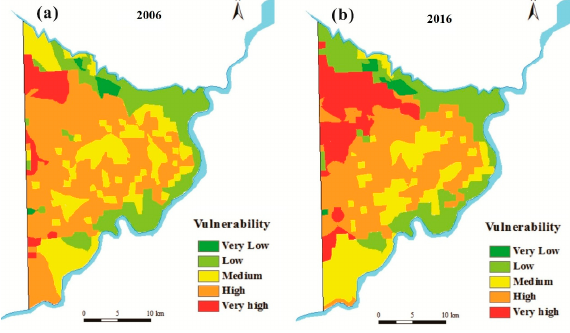
Figure 5. Spatial maps of land use types ( a , b ); depth to groundwater ( c , d ); river distance ( e ); aquifer